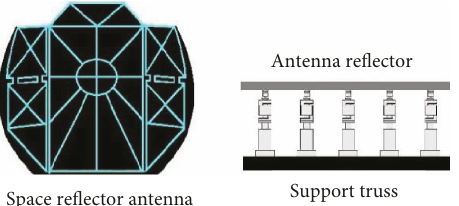
Figure 1: The active adjustment system of a 5-meter deployable antenna.